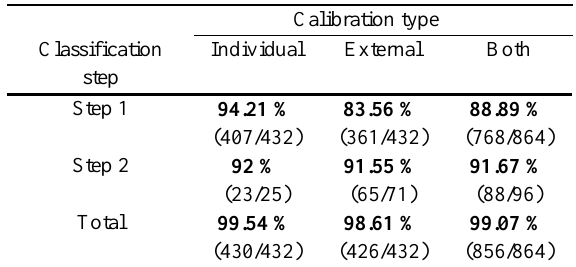
Table 4. Single eye movements correctly classified in stage 1.